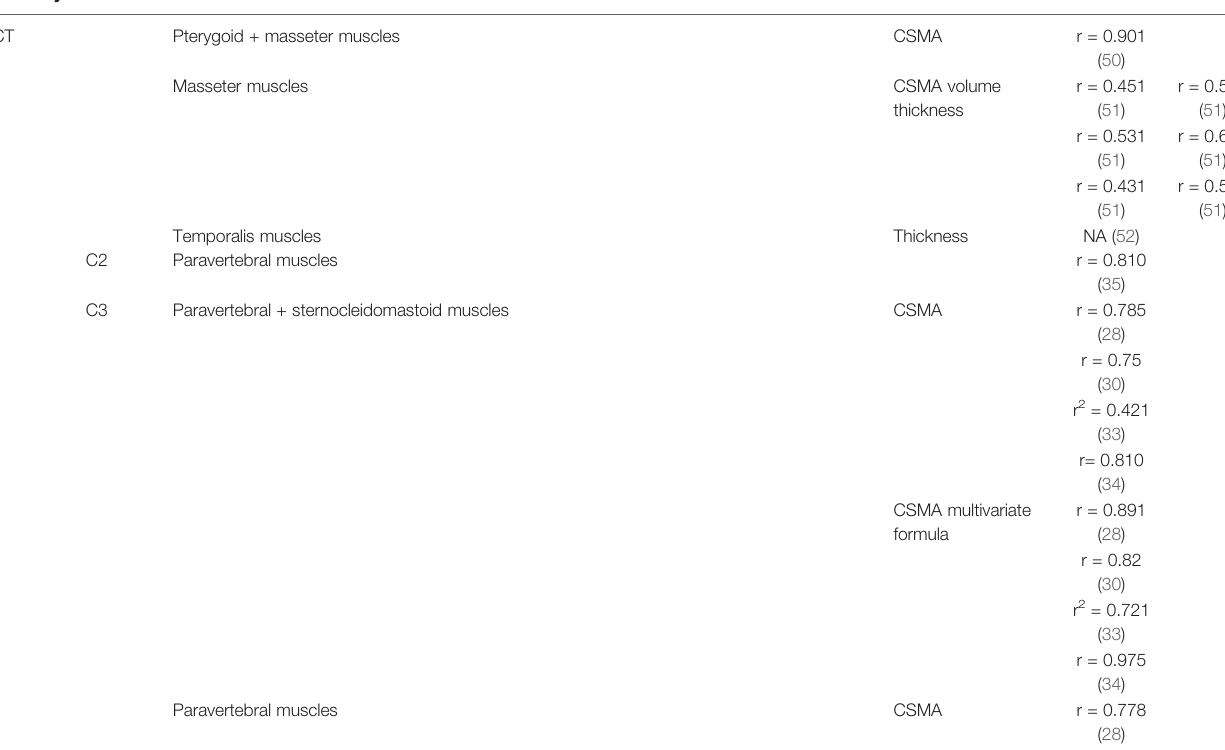
TABLE 1 | Different skeletal muscle mass measurement methods and their correlation with skeletal muscle mass measurement on CT at level L3 and C3. Modality